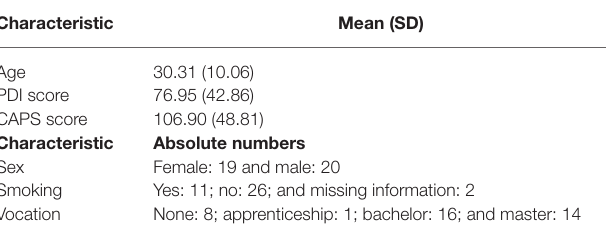
TABLE 1 | Participants’